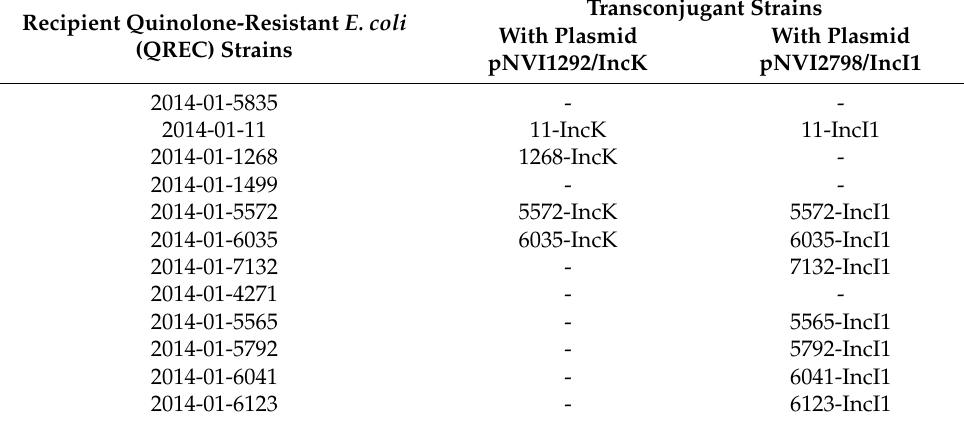
Table 7. Transconjugant strains